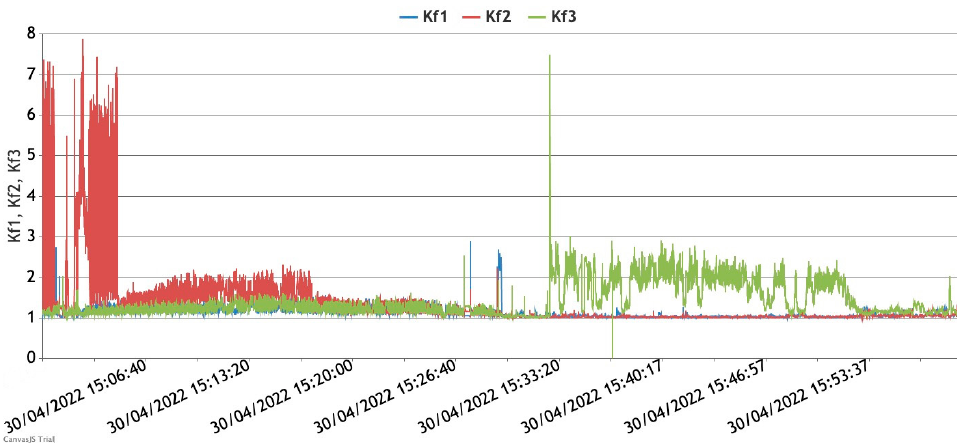
Figure 7. Calculated K-factor Kf1, Kf2, Kf3 graph for phase currents I1, I2, I3